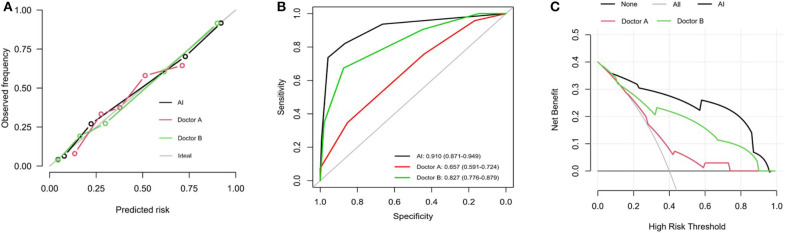
Performance of predictive value of AI index. (A) Calibration plots for prediction of AI, Doctor A and Doctor B. Calibration curves depict the calibration of the nomogram in terms of agreement between the predicted risk and outcomes. The 45° gray ideal line represents a perfect Prediction. The closer the dotted line fit is to the ideal line, the better the predictive accuracy of the diagnosis and nomogram is. (B) ROC curves for prediction of AI, Doctor A and Doctor B. (C) DCA analysis curves for radiodiagnosis of AI, Doctor A and Doctor B. It showed that if the threshold probability is between 0.09 and 0.96, then using the AI index adds more benefit than testing either all or no patients.